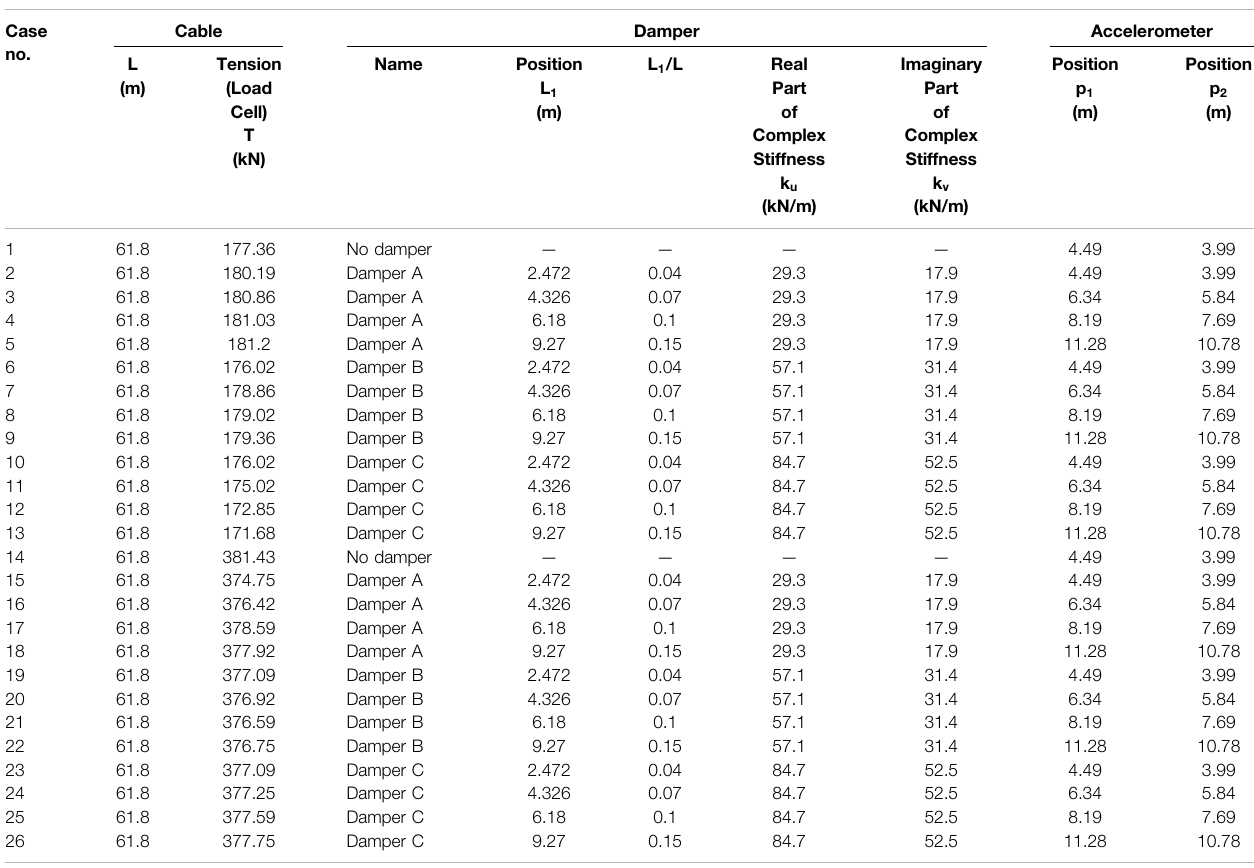
TABLE 8 | Test cases in experimental veri fi cation. Case no.